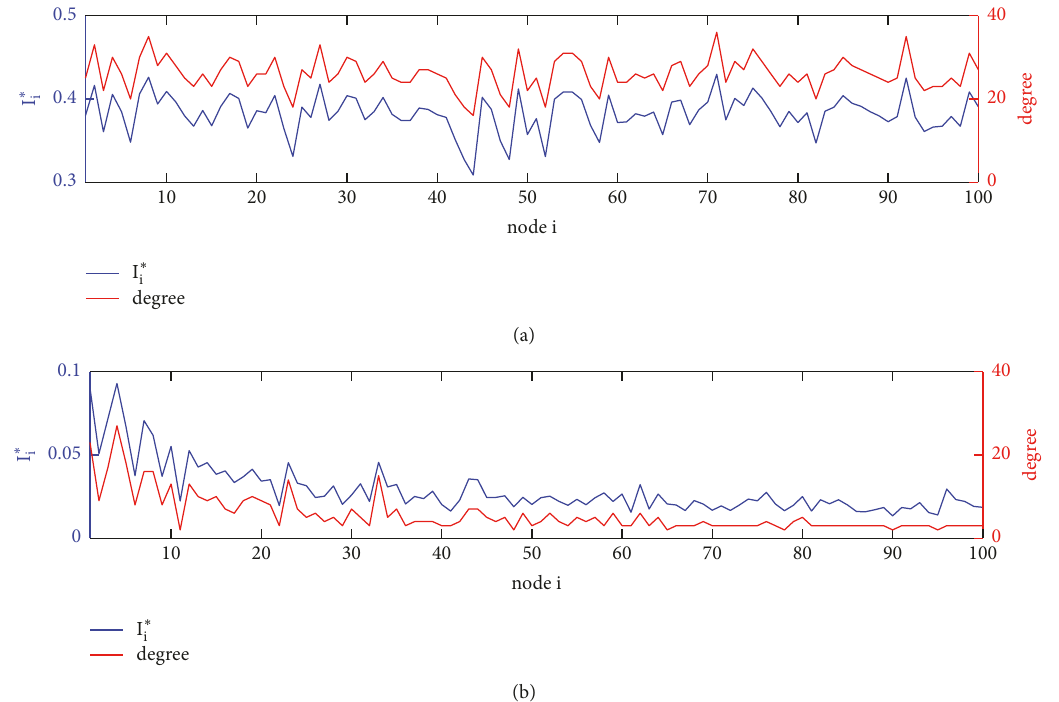
Figure 5: The correlation between the node degree (red solid line) and its infected equilibrium state (blue solid line) for NW small-world (a) and BA scale-free networks